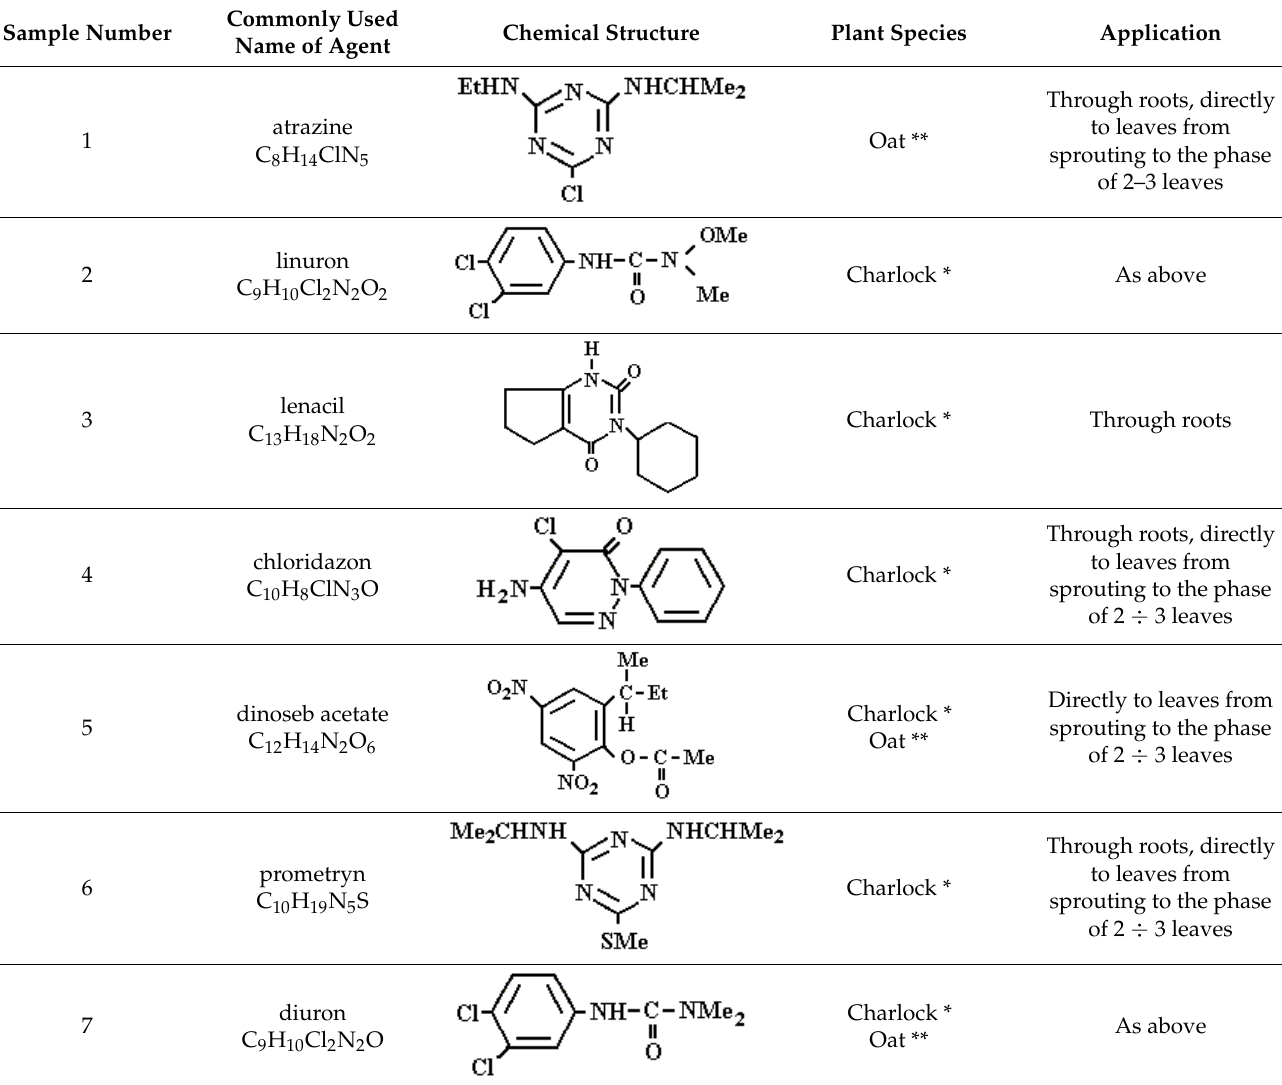
Table 2. Species of plants and methods of herbicide application.